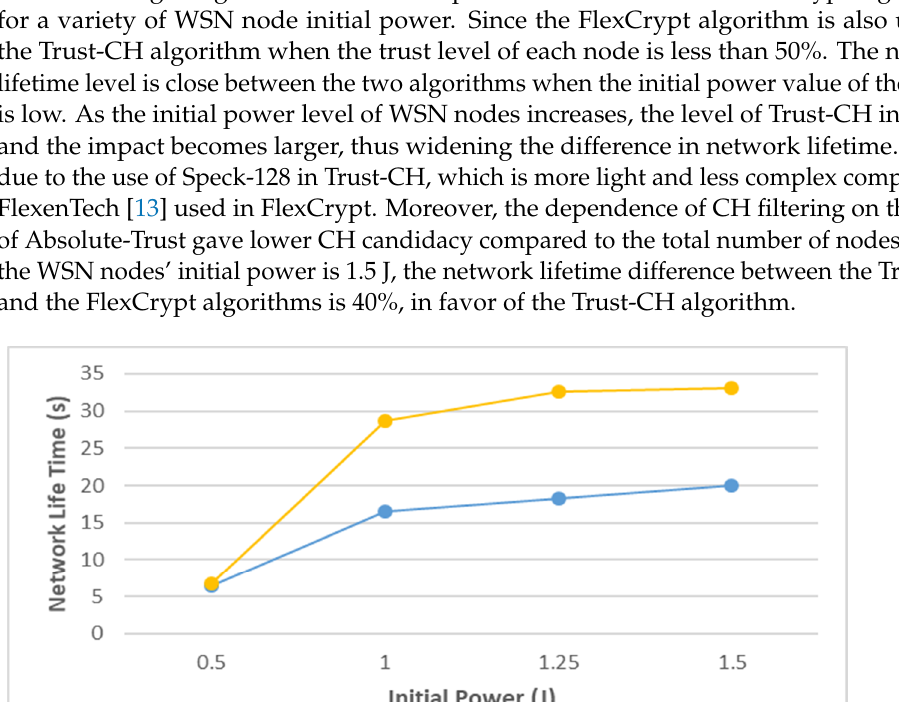
Figure 11. Comparison of Trust-CH and FlexCrypt on network lifetime.